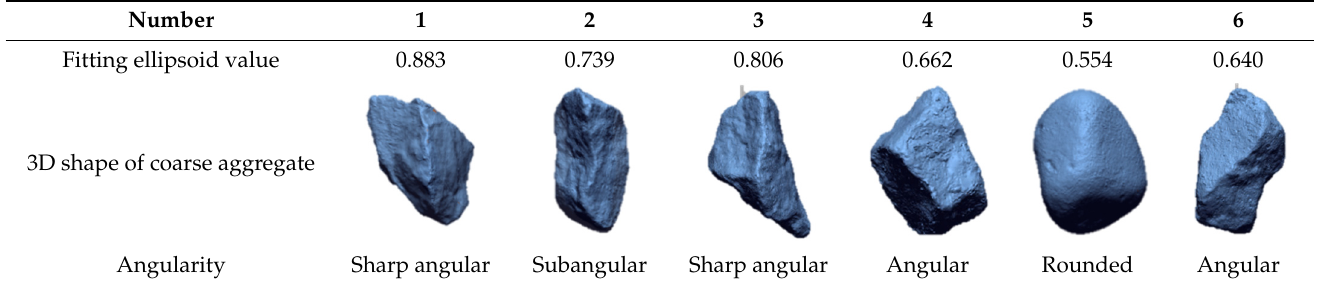
Table 3. Table 3. Table 3. Table 3. Table 3. Evaluation of angular characteristics of typical aggregate samples. Table 3. Evaluation of angular characteristics of typical aggregate samples. Table 3. Evaluation of angular characteristics of typical aggregate samples. Table 3. Evaluation of angular characteristics of typical aggregate samples. Table 3. Evaluation of angular characteristics of typical aggregate Table 3. Evaluation of angular characteristics of typical aggregate samples. Table 3. Evaluation of angular characteristics of typical aggregate samples. Table 3. Evaluation of angular characteristics of typical aggregate samples.